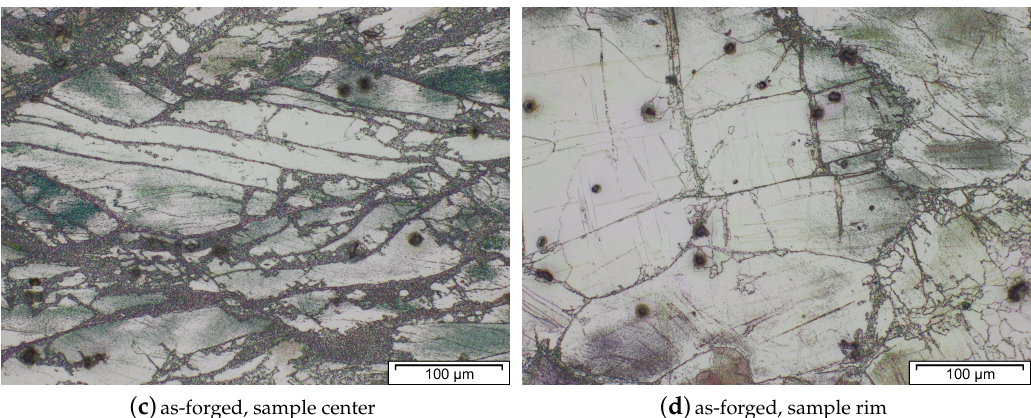
Figure 16. Microstructure of AZ91 in consecutive processing steps: ( a )as-cast, ( b )homogenized at 425 ◦ C for 24h. Forging took place using a material temperature of approx. 300 ◦ C, die temperatures of 280 ◦ C and a ram speed of 10mms − 1 . The as-forged microstructures of parts cooled at air are shown in: ( c )center area having high degree of deformation and ( d )flange area with a lower degree of deformation.